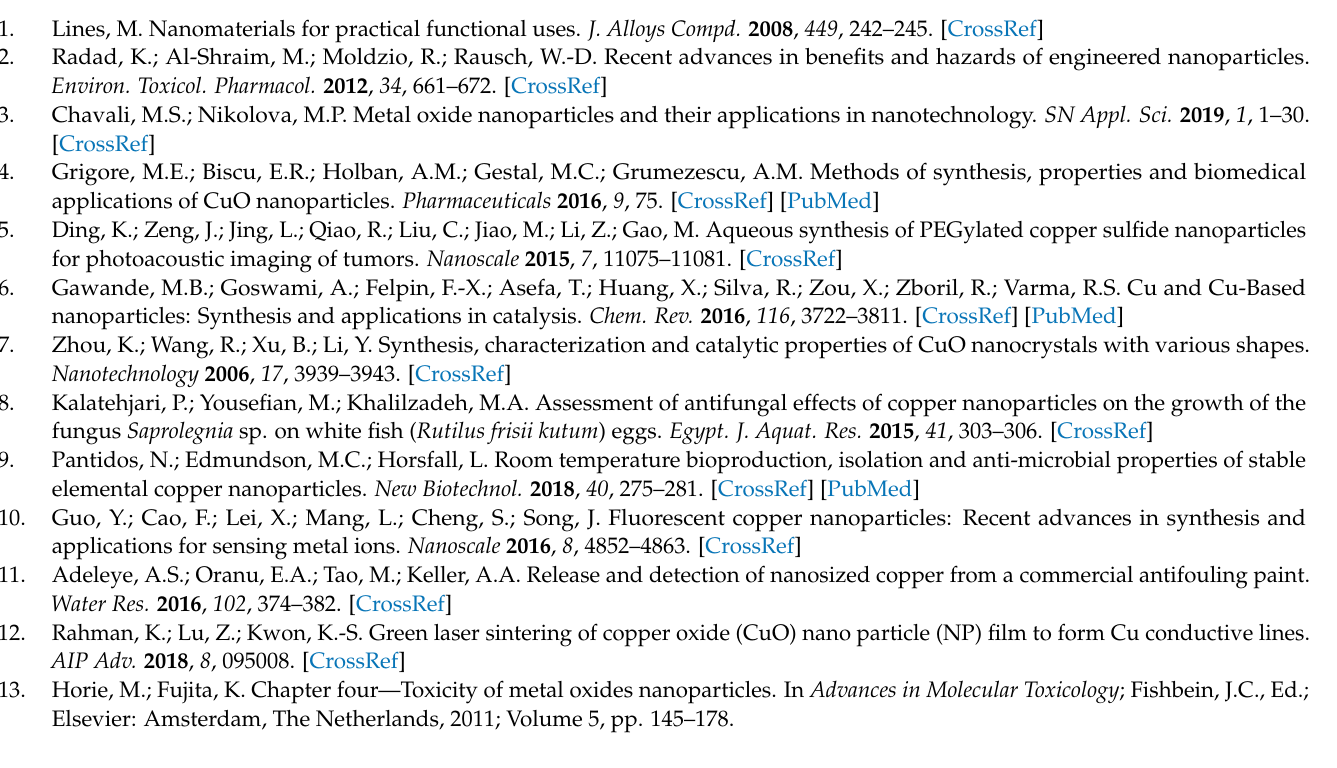
Figure S3: Composition analysis by energy-dispersive X-ray spectroscopy (EDX) of the constituents showing the presence of copper and oxygen elements, Table S1: Results of the 96 h LC50 experiment of copper oxide nanoparticles (CuONPs) in Nile tilapia fingerlings according to Finney’s probit